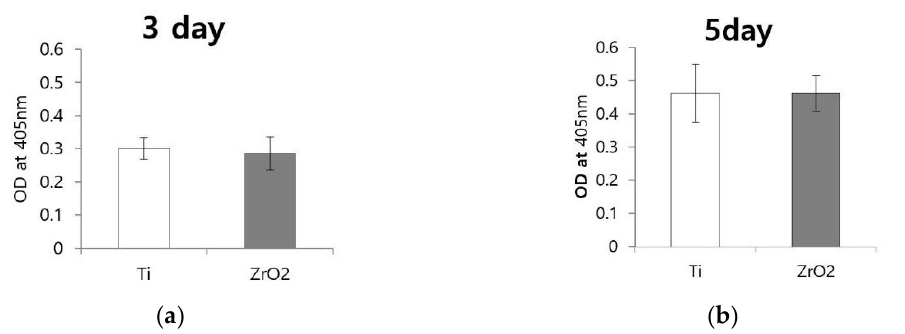
Figure 6. Tartrate-resistant acid phosphatase (TRACP) activity of osteoclasts on Ti disks and zirconia disks. ( a ) Absorbance values after three days of cell culturing; there was no significant difference between the two groups; ( b ) Absorbance value after five days of cell culture; there was no significant difference between the two groups. ( p > 0.05; the bar represents mean ± SD).